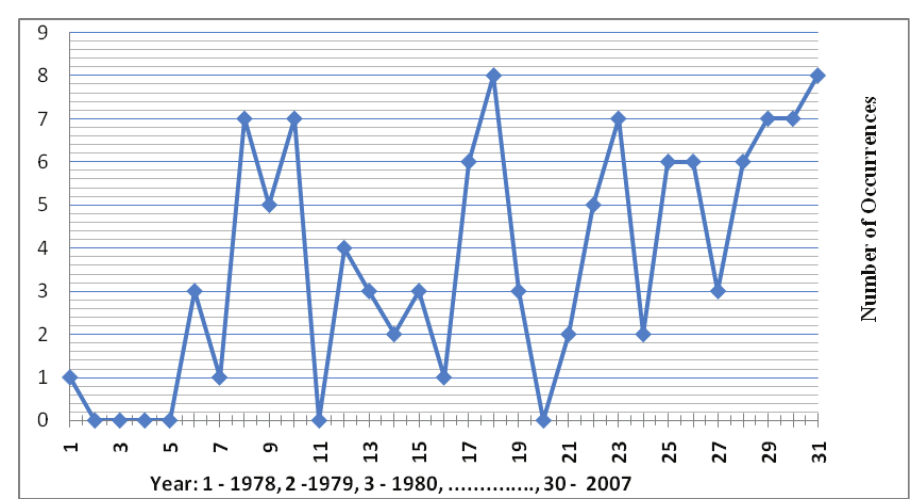
figure 3. trend in occurrences of building collapse in lagos metropolis